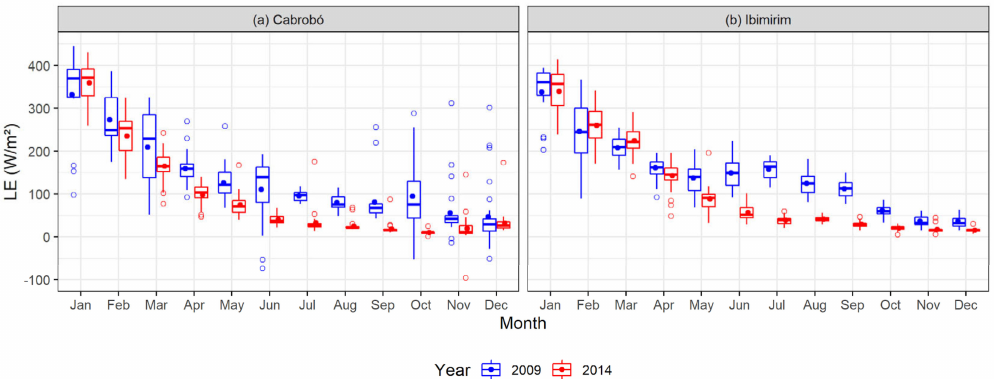
Figure 8. Monthly boxplots of hourly simulated latent heat flux (LE) in the Cabrob ó and Ibimirim sites in 2009 (wet year) and 2014 (dry